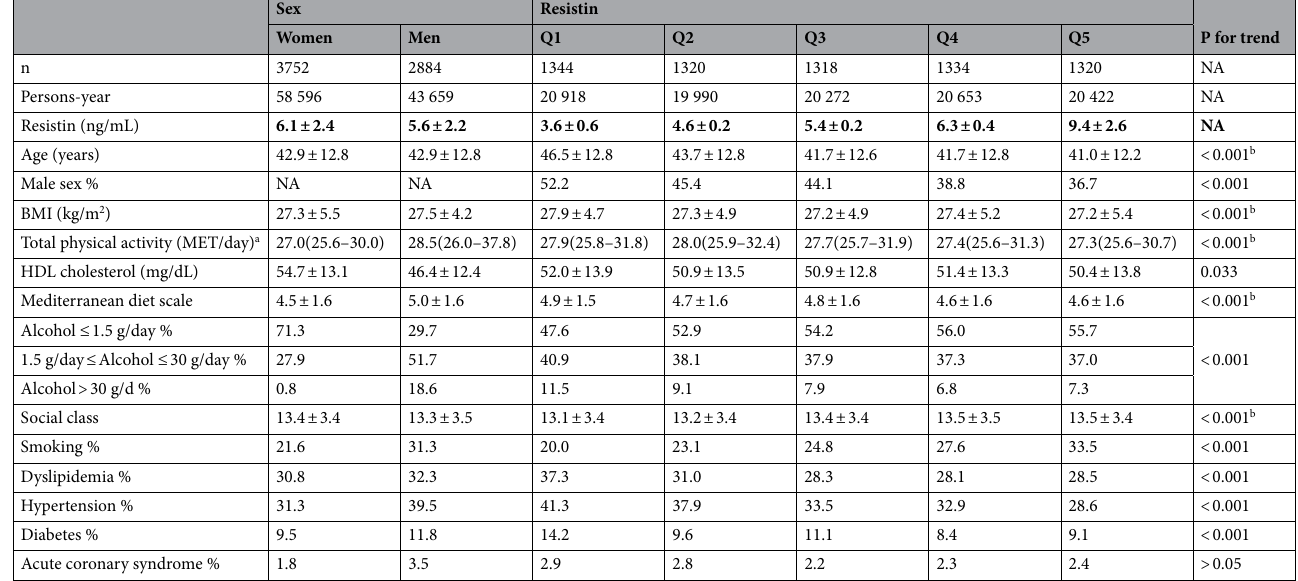
Table 1. Number and characteristics of the participants at the time of enrollment, according to sex and quintiles of resistin. a Median and interquartile range. b Trends are for quintiles of these variables across resistin quintiles. Resistin values are in